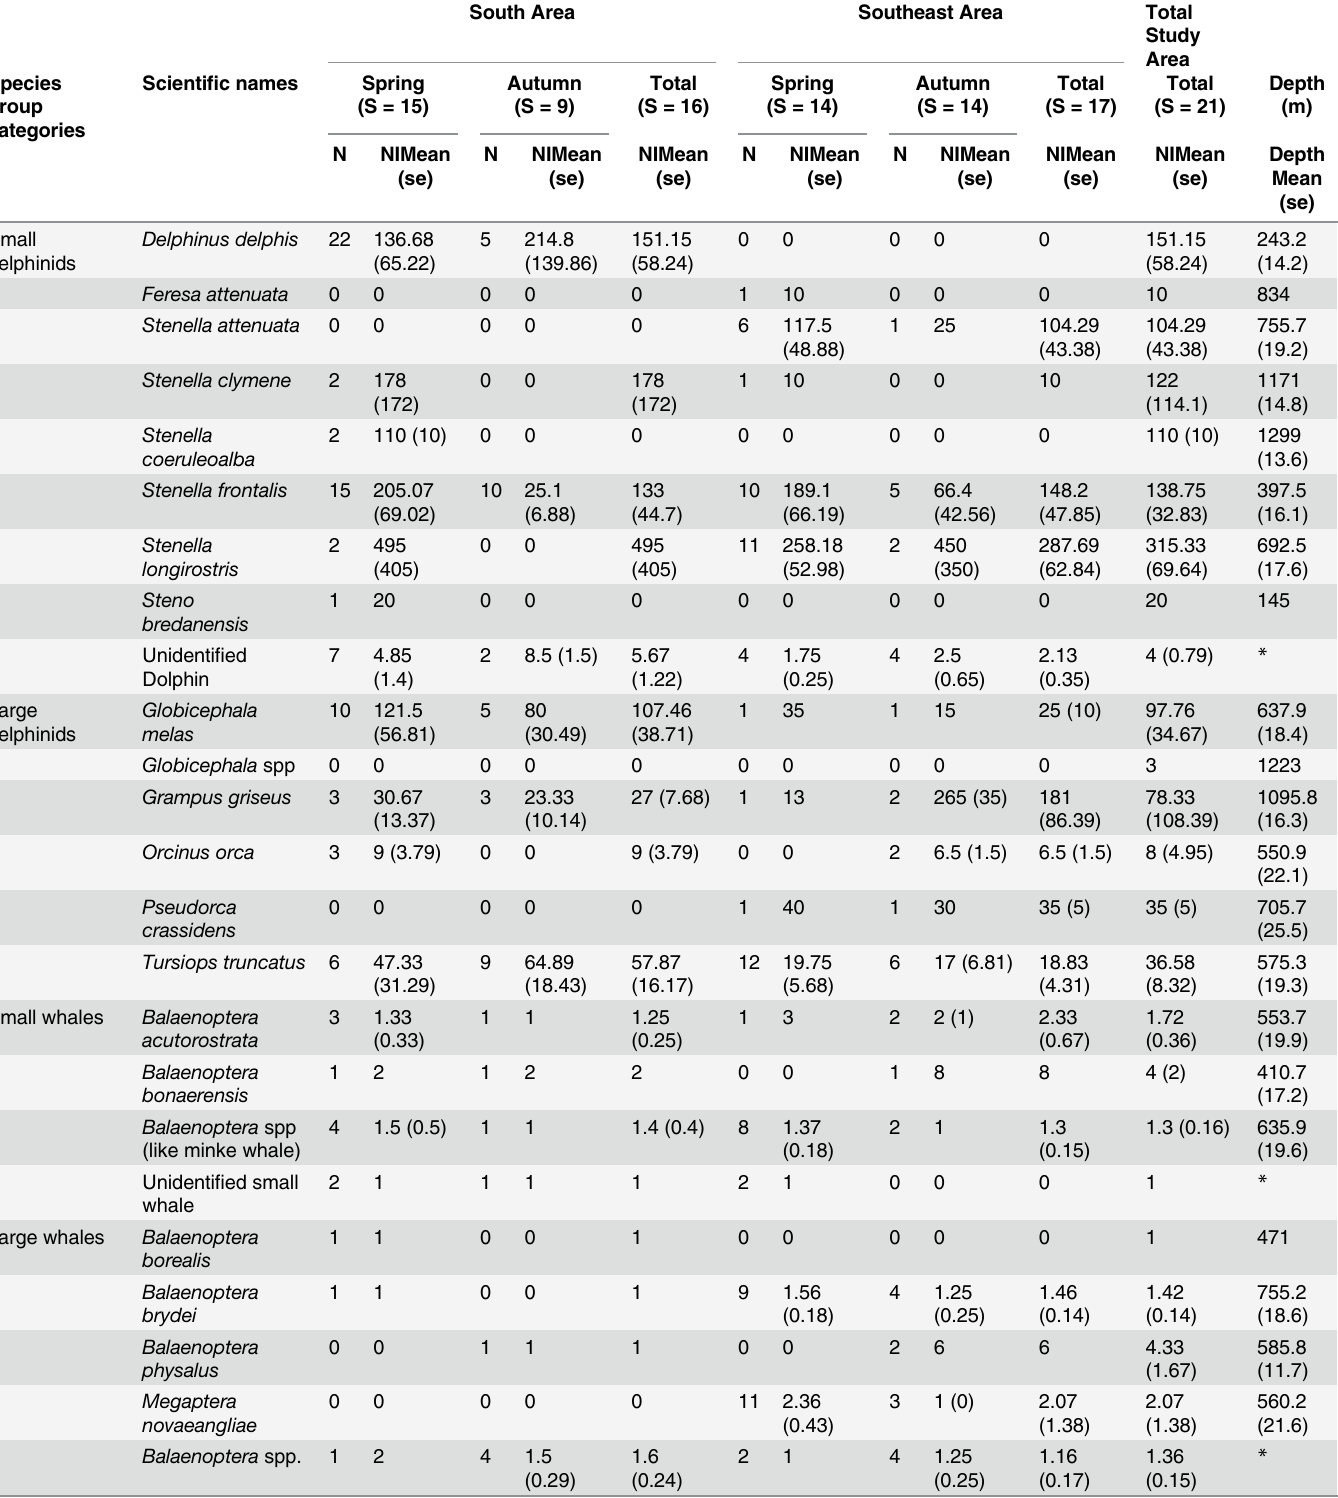
Table 2. Species richness and summary of cetacean sightings distribution considering species, group categories, seasons, areas and